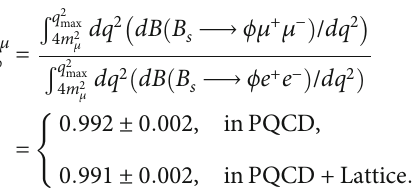
Figure 3. As a comparison, the currently available LHCb ⟶ ϕμ + μ − decay measurements for these observables of B s in the six q 2 bins [31] are also shown by those crosses explic- itly. One can see from Figure 3 that ð q 2 Þ , although (1) For the longitudinal polarization F L both PQCD and “ PQCD+Lattice ” predictions all agree well with the LHCb measurements in the six bins, our theoretical predictions in the region of the fourth and fi fth bin are little larger than the mea- sured ones (2) For the CP-averaged angular coe ffi cients S 3 , 4 , 7 ð q 2 Þ , the PQCD and “ PQCD+Lattice ” predictions agree very well with each other and are consistent with the LHCb results within the still large experimental errors. For the last two high- q 2 bins, the LHCb results of S 3 ( S 7 ) are a little larger (smaller) than our theoretical predictions